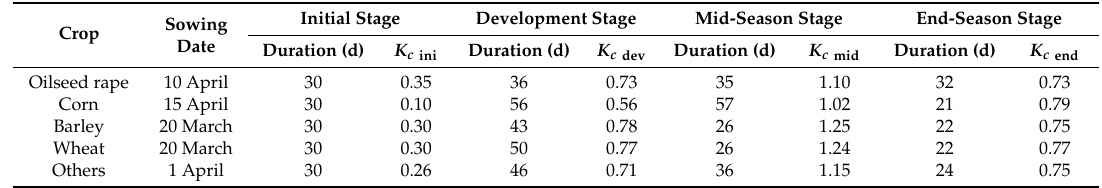
Table 1. K c values for different crop growth stages within the HRB in 2007 and